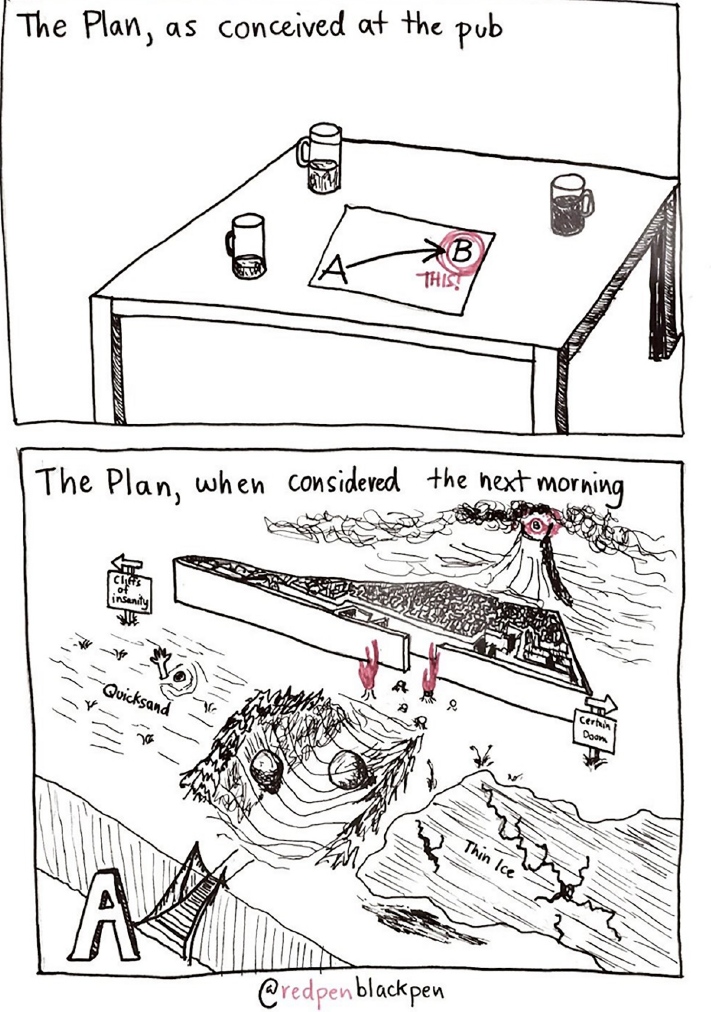
Fig 5. Focus on the prize. Generally, your plan seems a lot more straightforward than the way things actually happen. It’s important to remain flexible about how you achieve your goals and, indeed, what those goals actually are. But also remember that other people’s paths were not necessarily as smooth as they